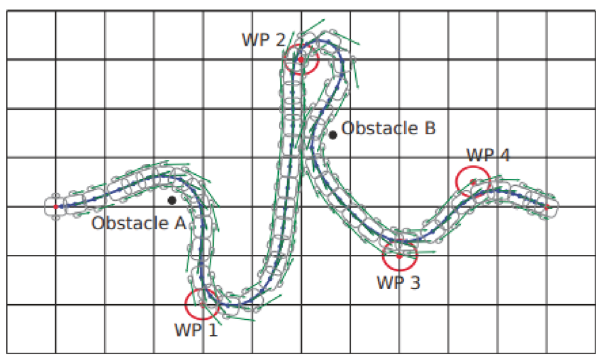
Figure 4: iCab with